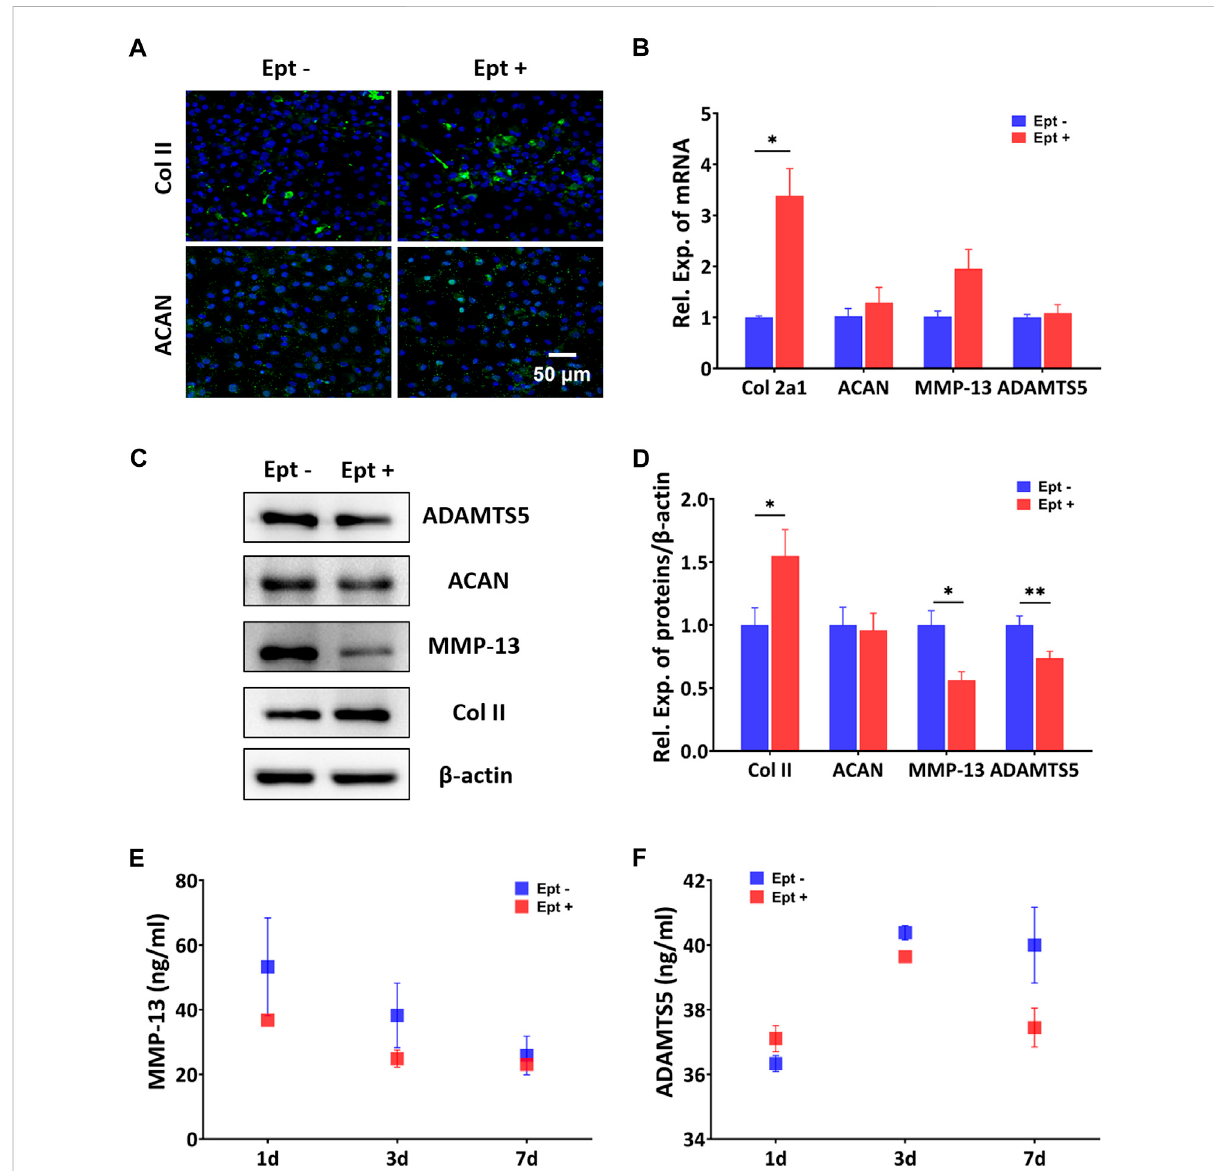
FIGURE 4 Regulatory effects of Ept on catabolic and anabolic dynamics in hOACs. (A) Immuno fl uorescent staining against Col II and aggrecan (ACAN) in EptorvehicletreatedhOACs. (B) PCRresultsofColII,ACAN,MMP-13,andADAMTS5( n =3). (C) Representativewesternblotdetection ofADAMTS5, ACAN, MMP-13, Col II, and β -actin ( n = 3). (D) Normalized quantitative data from western blot assay in Ept or vehicle treated hOACs. (E and F) Elisa detection of ADAMTS5 and MMP-13 levels in culture medium (n = 3). Mean ± SD, p * < 0.05, p ** <